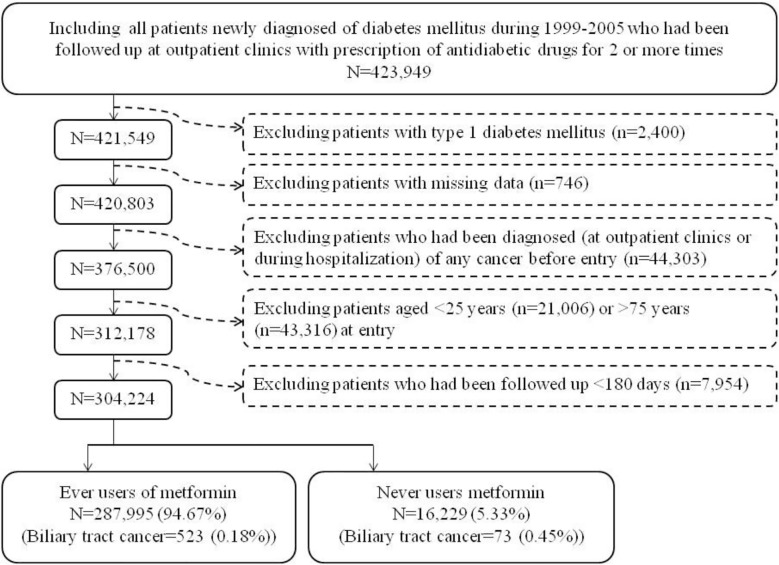
The procedures in creating the unmatched original cohort of ever and never users of metformin by using the reimbursement database of the National Health Insurance of Taiwan.